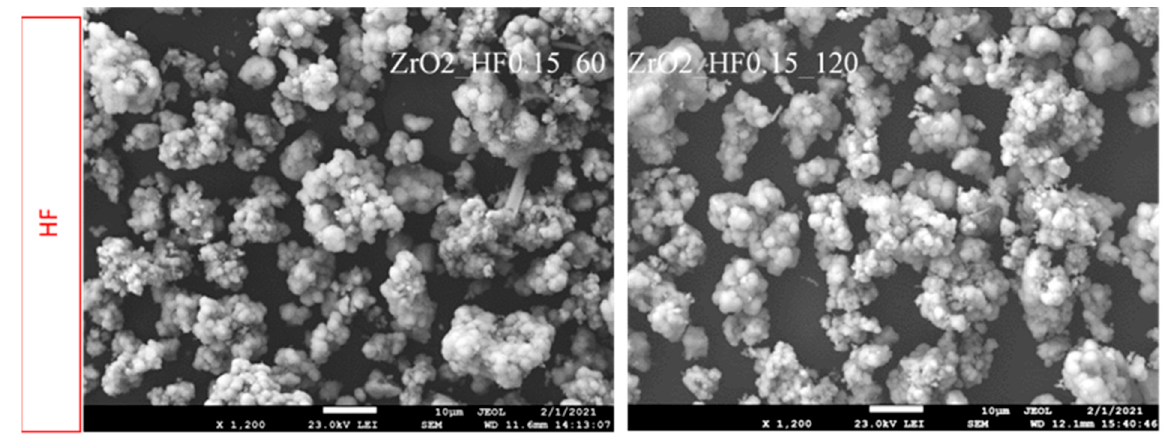
Figure 2. SEM images comparing the degree of agglomeration of zirconia powders after etching with different acids.